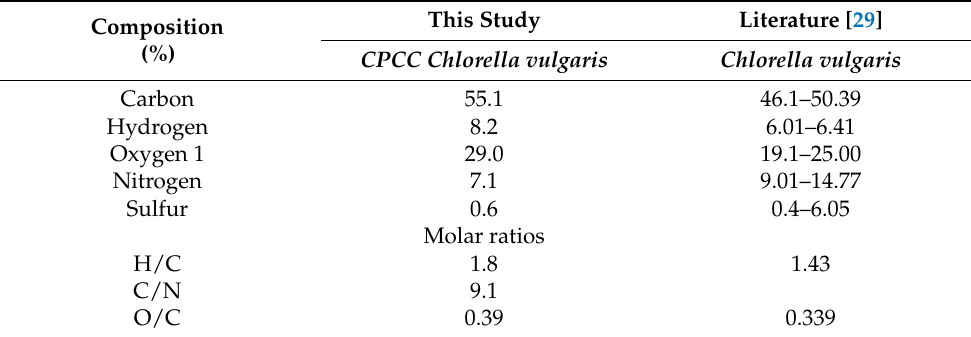
Table 1. Elemental analysis of the cells of CPCC90 Chlorella vulgaris using combined CHNS and EDX elemental analysis. Reported results are average values between repeats with ± 0.003 being the largest standard deviation.